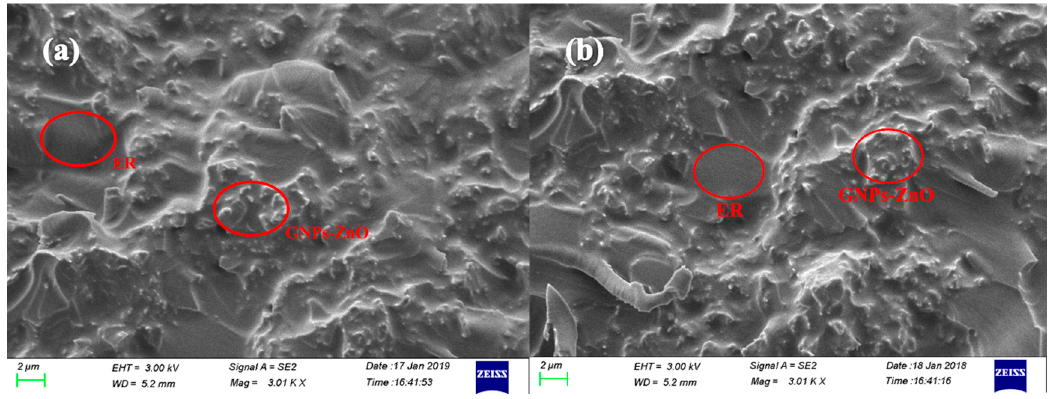
Figure 8. SEM micrographs of two different fracture surfaces of the same GNP-ZnO/ER composites.